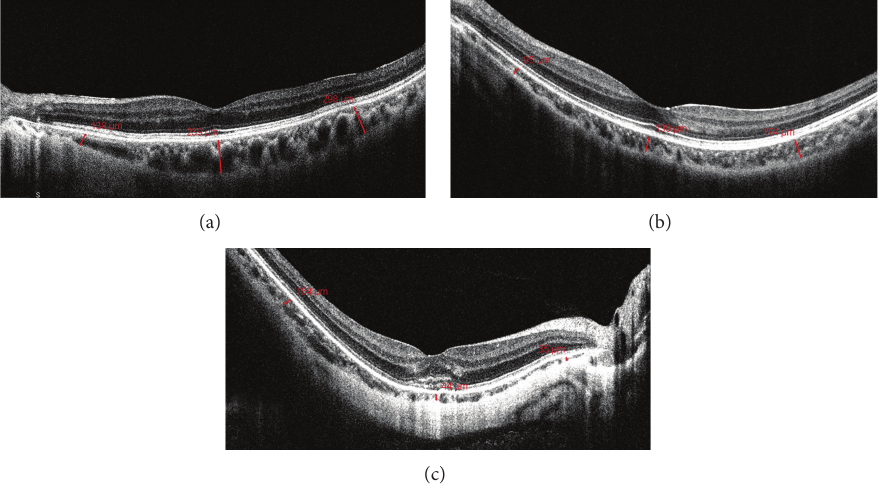
Figure 1: Optical coherence tomography (OCT) images using enhanced-depth imaging. The choroidal thickness (red line) is defined as the vertical from the outer surface of the hyperreflective line ascribed to the retinal pigment epithelium (RPE) to the hyperreflective line of the inner sclera border (a). Representative scan of a control individual (b). Representative scan of an individual with high myopia without choroidal neovascularization (CNV); note that the choroid is thinner than in the control but thicker than in high myopia with CNV (c). Representative scan of an individual with high myopia with CNV; note that the choroid is thinner than that of control or high myopia without